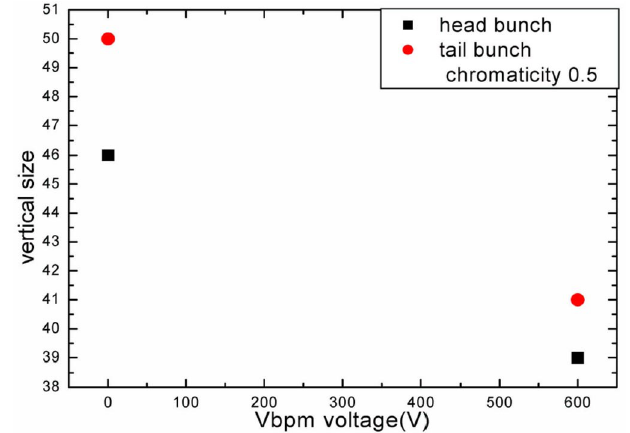
FIG. 30. (Color) Vertical beam size of the first and last bunch in a train as a function of the BPM bias voltage at BEPC in 2004 [38]; the beam size was measured by a streak